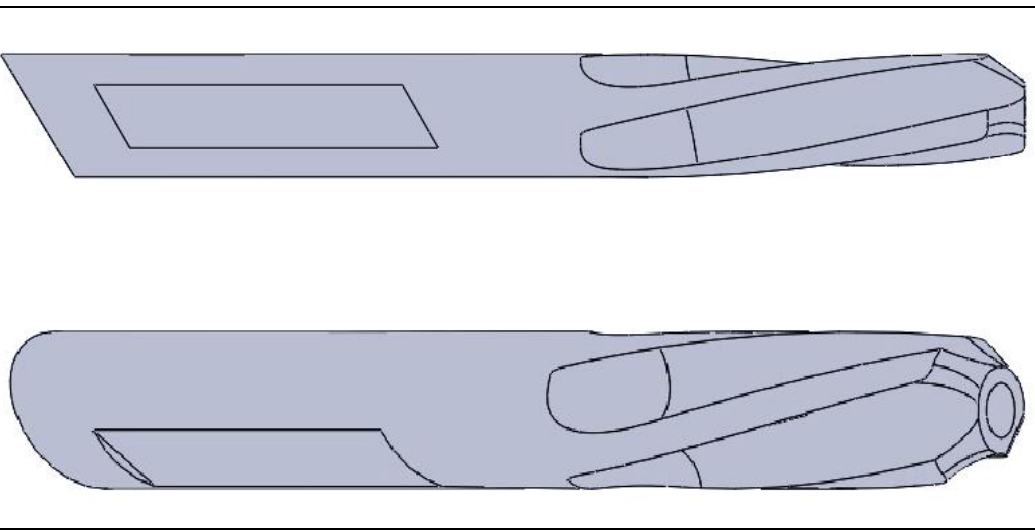
Figure 2. Generated model for the helical screw. Reprinted from Ref. [21].